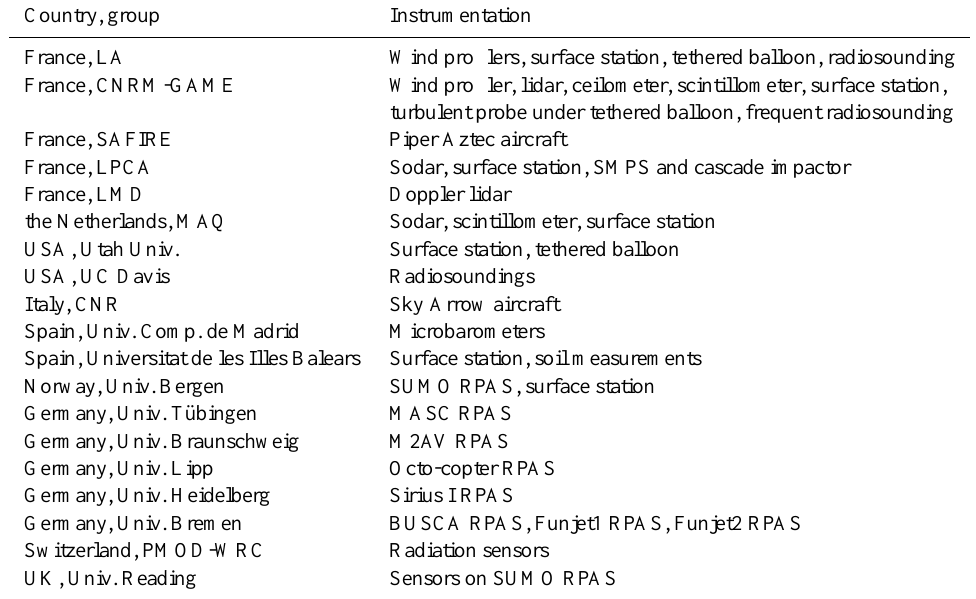
Table 1. Groups involved in the BLLAST campaign and the instrumentation they implemented. Country, group Instrumentation